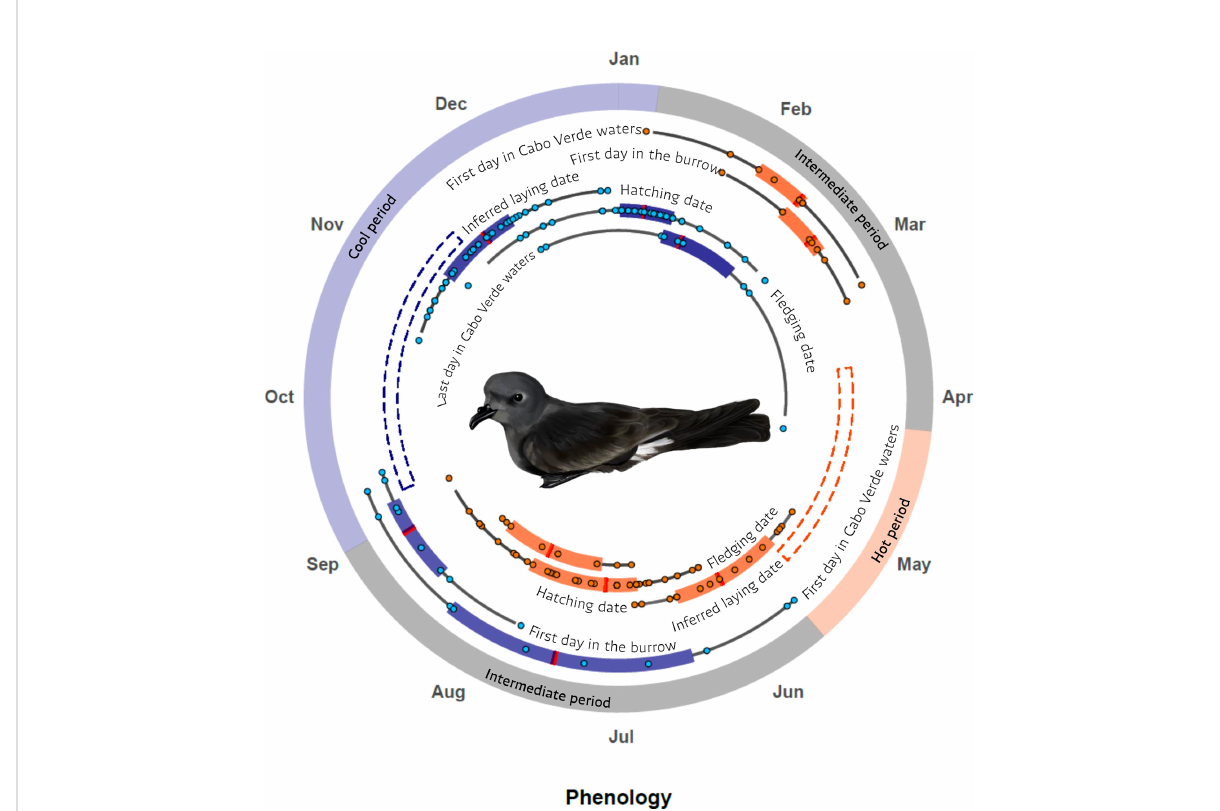
FIGURE 1 Phenology of the hot and cool populations of the Cape Verde storm-petrel in Cima Islet (Cabo Verde) based on nest monitoring and light-level geolocators. Blue shading indicates the phenology for the cool population while red/orange shading indicates the phenology of the hot population. Laying dates were inferred from hatching dates based on an incubation period of 42 days. Hot and cool seasons correspond to periods when only hot or cool breeders can be found in the colony whereas intermediate periods correspond to periods when birds from both populations can be found in the colony. Each boxplot shows the median, the fi rst and third quartiles at the end of the box, and the fi rst and 99th quantiles on the tails. Artwork by María Jesús Mallea